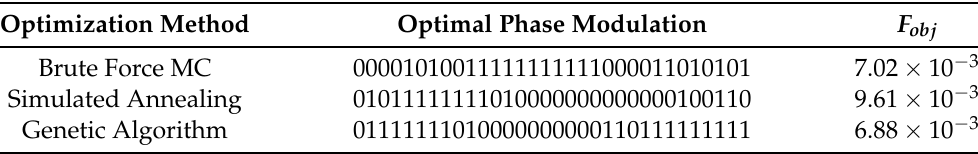
Table 5. Comparison of various phase-only optimization methods for the target intensity profile in Figure